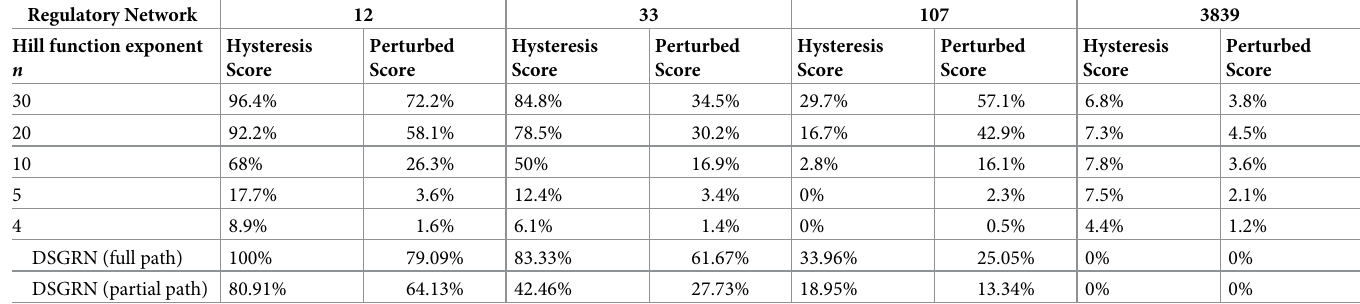
Table 1. The regulatory network number comes from the ranking of the hysteresis score [18]. The bottom two rows indicate the full path and partial path hysteresis scores obtained from DSGRN. The first column indicates the exponent of the Hill function used in the ODE model for the regulatory network, e.g. (1). The two columns under each regulatory network number indicate the percentage of continuation computations that result in a hysteresis curve. The first column assumes the parameter value is in a region defined by